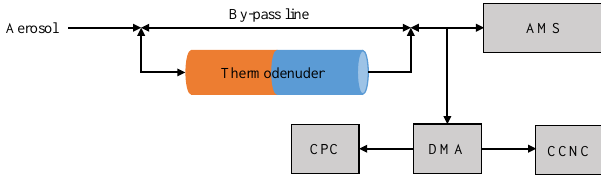
Figure 1. Schematic of the experimental setup for the hygroscop- icity, oxidation level, and volatility measurements. The sampling technique employs a TD to measure volatility, an AMS to study the oxidation level, and a CCNC to determine hygroscopic